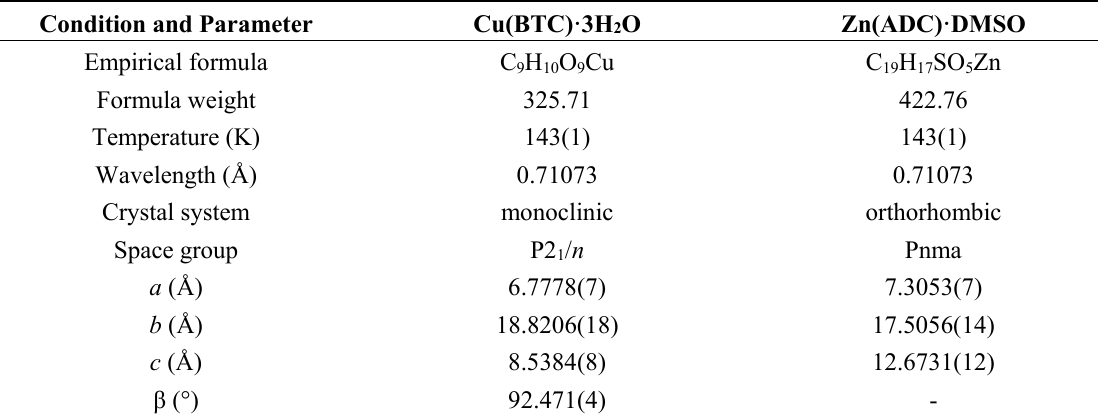
Table 1. Crystal data and structure refinement for the two metal coordination polymers. Condition and